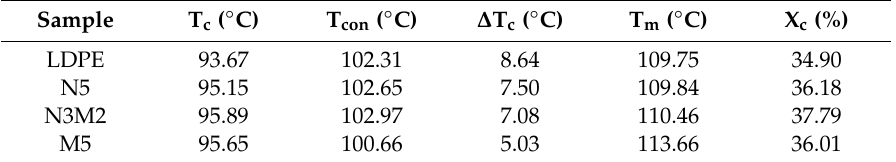
Figure 3. The heating and cooling curve of different samples. ( a ) Heating curve of different samples; ( b ) Cooling curve of different samples. Table 3. The melting peak and crystallinity of different samples.